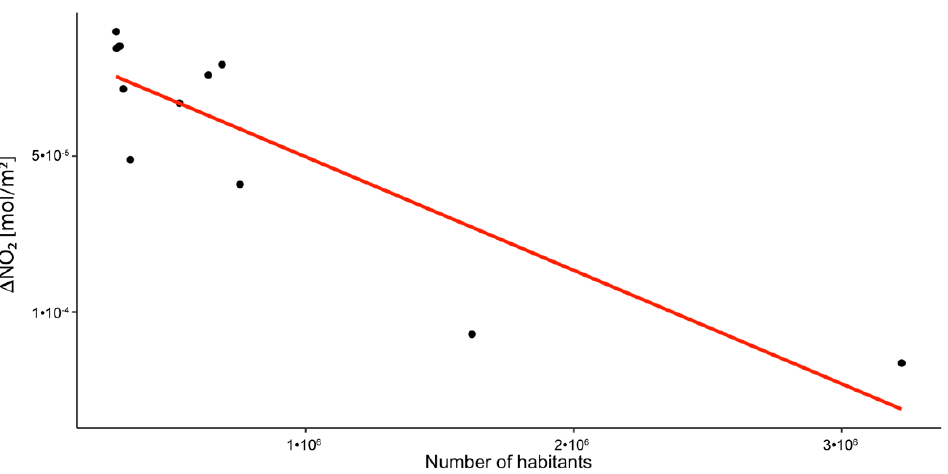
Figure 9. Number of inhabitants versus variation of tropospheric vertical column of NO 2 . The red line is the fitted linear function.